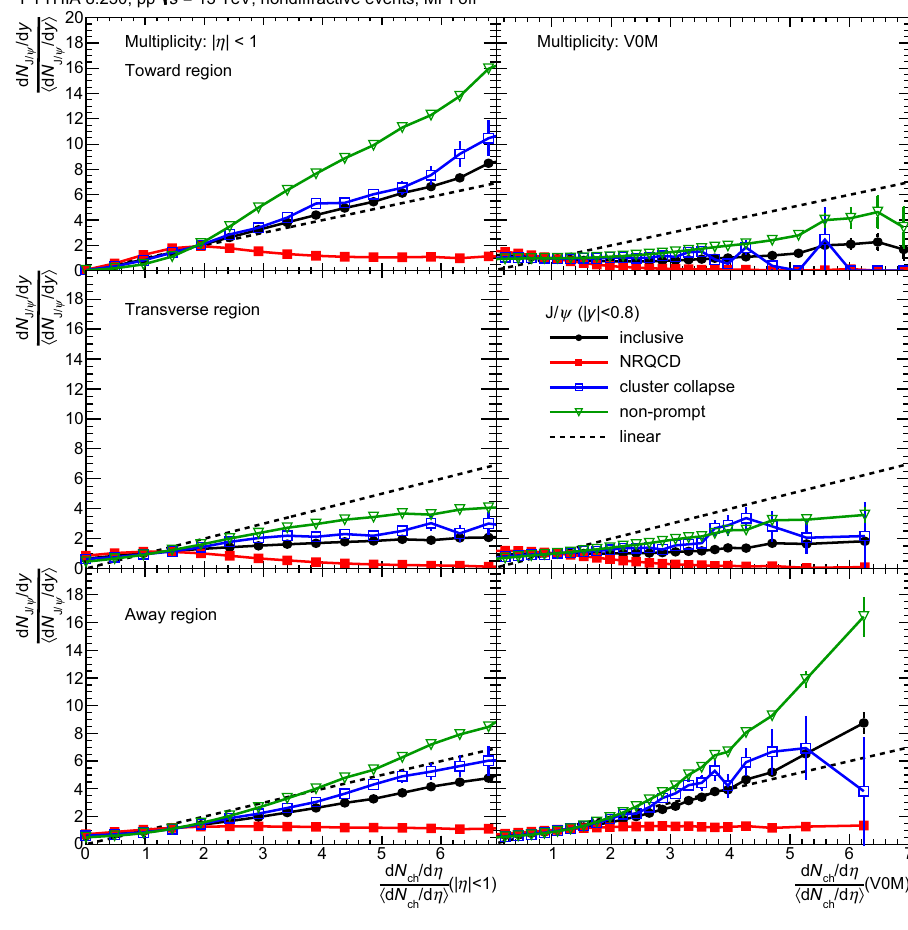
= 13 TeV, nondiffractive events, MPI off s PYTHIA 8.230, 02468101214161820 〉 y region| < 1 η Multiplicity: | / d ψ J / N Toward N d 〈 d